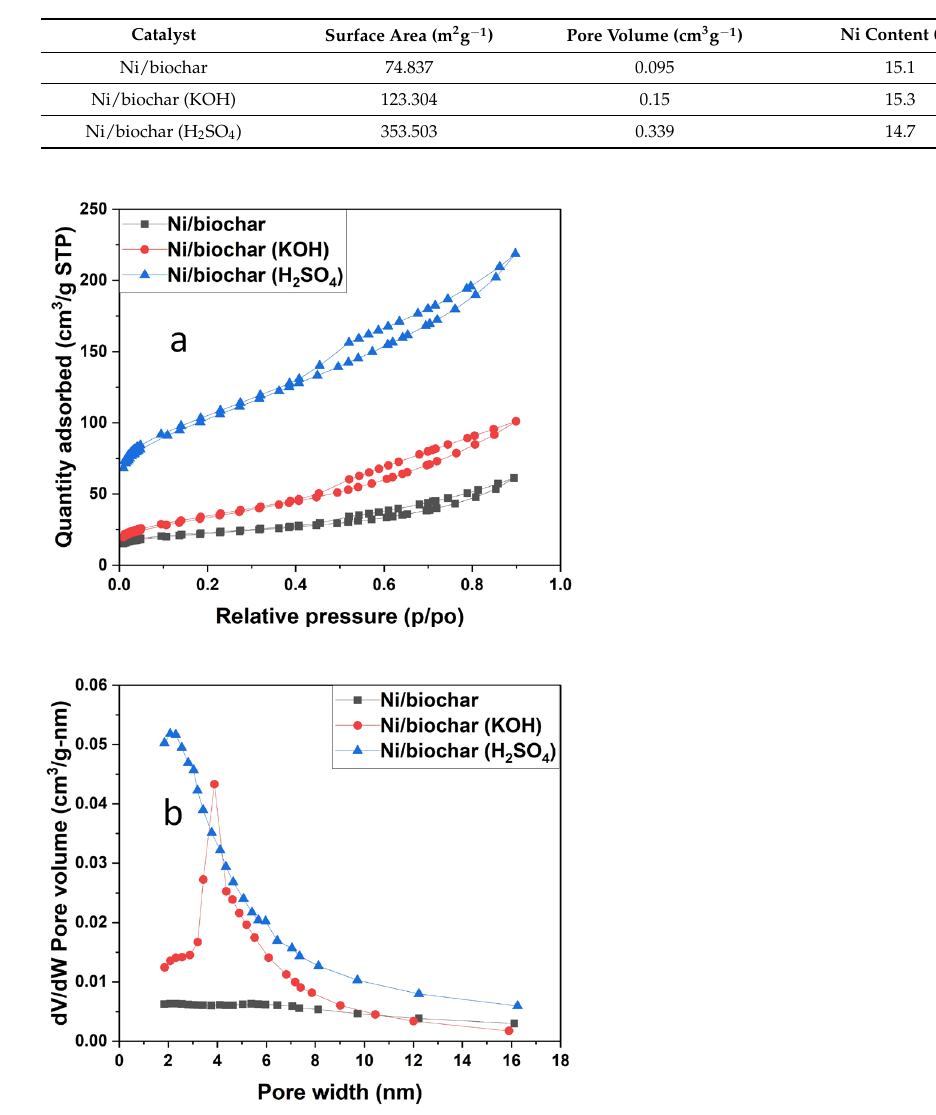
Table 1. Surface area and pore volume of Ni/biochar, Ni/activated biochar, and Ni/acidified biochar.